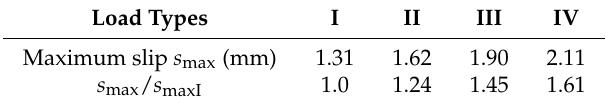
Table 3. Comparison of maximum slip at the end of the beam under four load